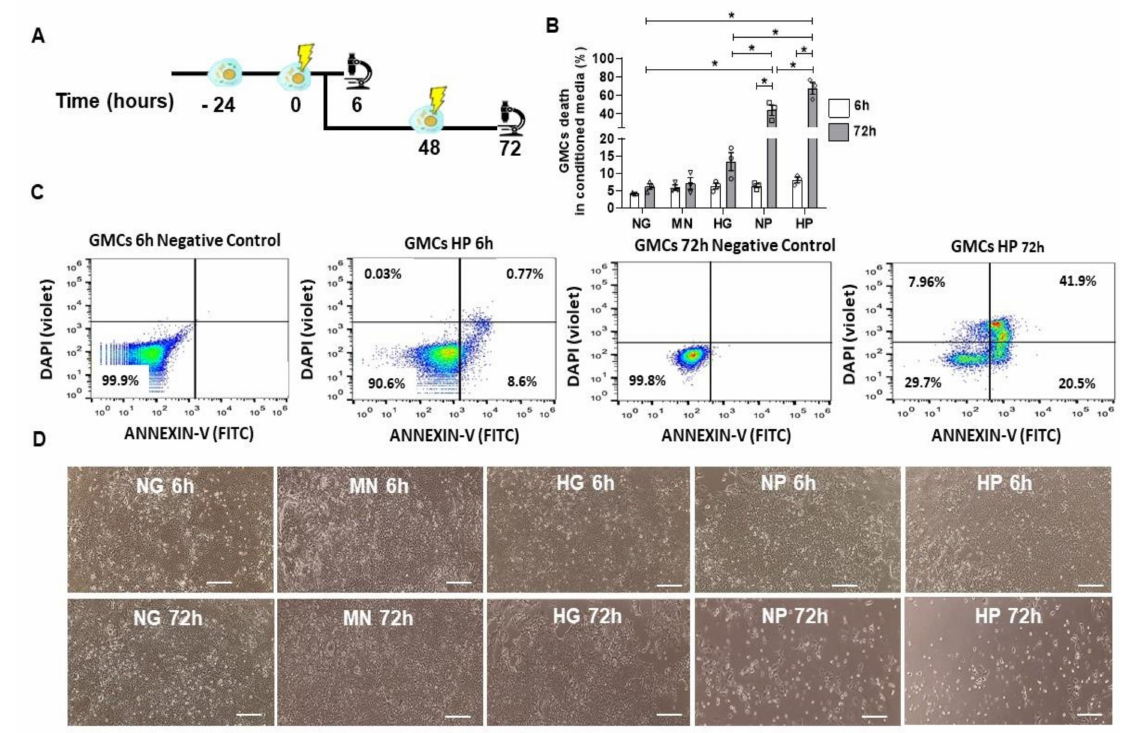
Figure 4. GMCs’ death induction after stress-conditioning at different time points. ( A ) Scheme of GMCs’ experiments for stress-conditioning at different time-points (6 h and 72 h). ( B ) Flow cytometry analysis of GMCs’ death after stress-media conditioning. NP and HP media caused an increase in cell death, in comparison to 6 h conditioning (* p < 0.05). ( C ) Flow cytometry gating and negative control for GMCs conditioned to HP media at 6 h and 72 h. ( D ) Light microscopy imaging of GMCs conditioned at 6 h and 72 h. NP and HP caused a visual morphology alteration, disturbing cell growth and culture plate occupancy after 72 h conditioning. Scale bars represent 200 µ m. Cell death (Annexin-V + and DAPI + ) in GMCs conditioned to stress media (normal glucose—NG, mannitol—MN, hyper glucose—HG, normal glucose + hydrogen peroxide—NP, hyper glucose + hydrogen peroxide—HP) during 6 h and 72 h time-points. Error bars represent mean ± SEM; n =